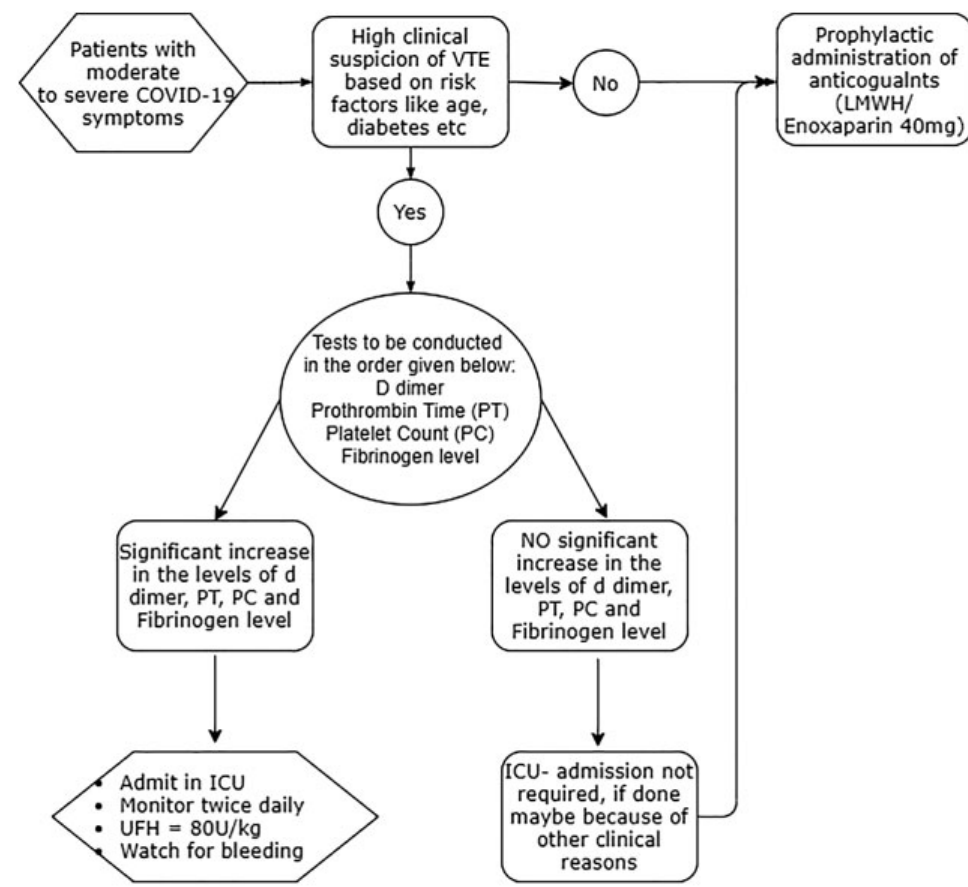
Fig. 5 Flow chart for management of COVID-19 associated VTE . Abbreviations: Prothrombin time (PT), Platelet count (PC), Intensive care unit (ICU), Low molecular weight heparin (LMWH), Un-fractioned heparin (UFH).